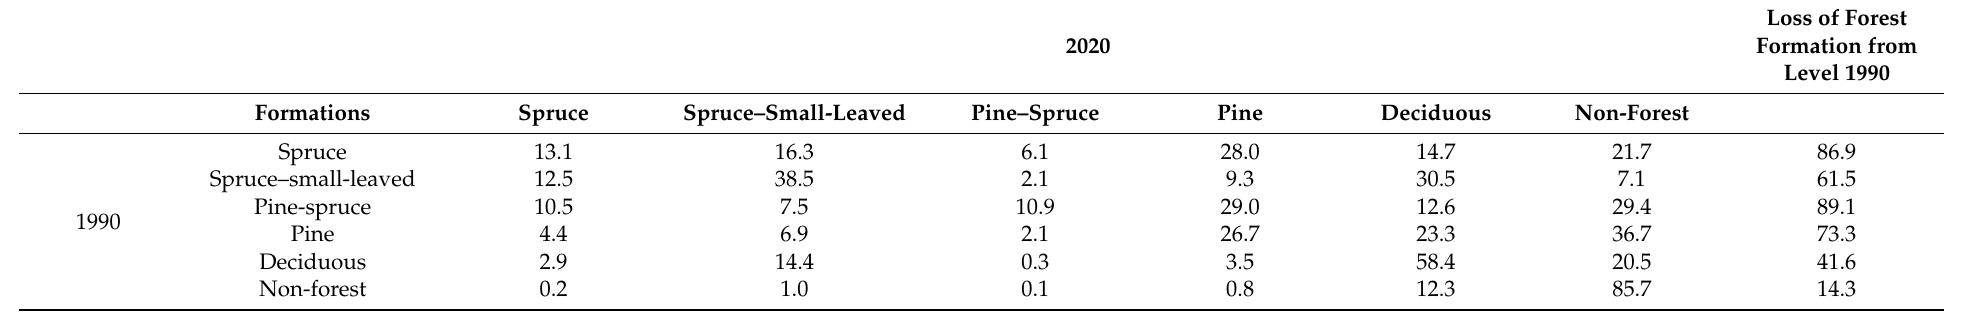
Table A4. Changes in the composition of coniferous formations in the period 1990-2020, loss of the area of forest formations relative to the 1990 level,